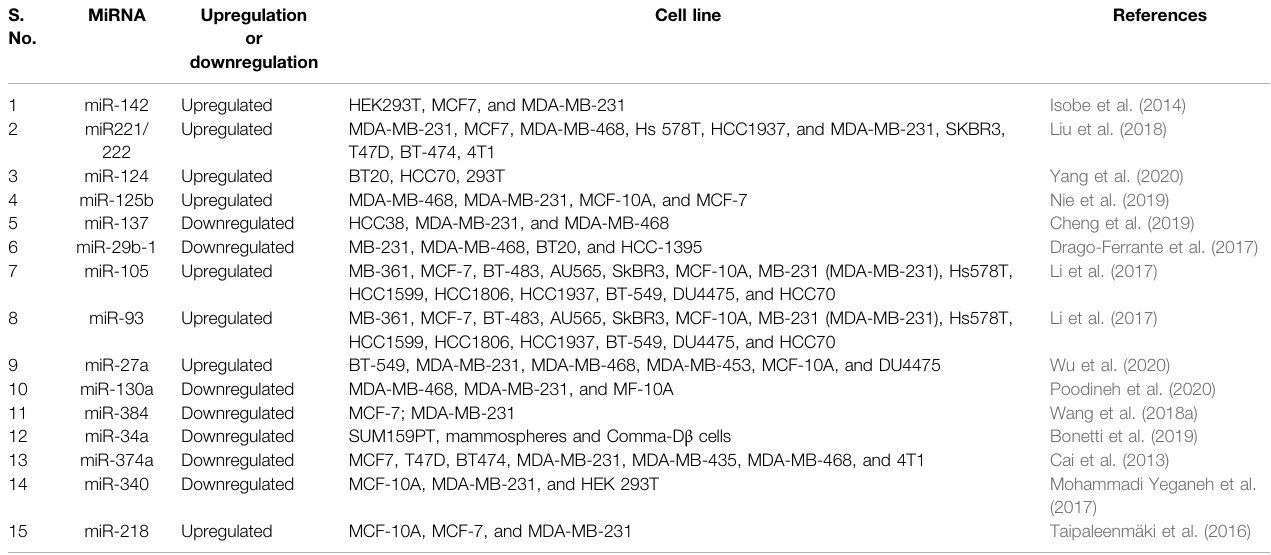
TABLE 1 | miRNAs impacting TNBC via the Wnt/ β -Catenin axis. S.